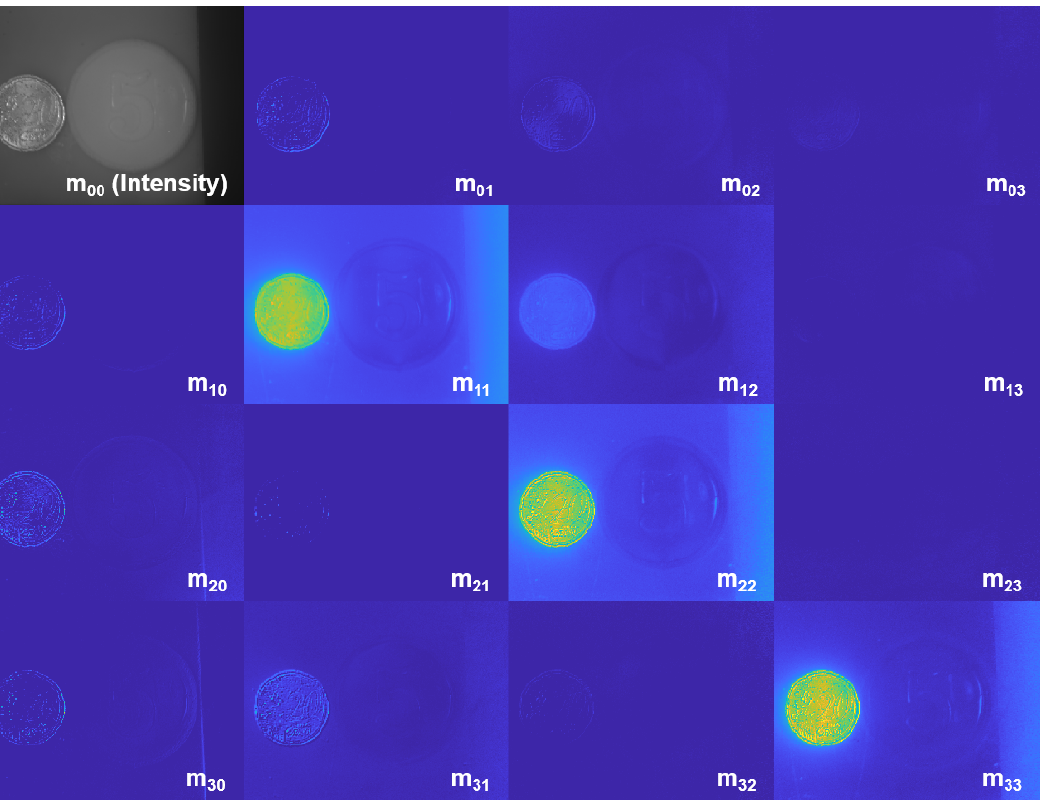
Figure 3. MM image of the scene in clear water. (Here, the MM elements m ij , i , j ∈ { 0,1,2,3 } are normalized by m 00 ).